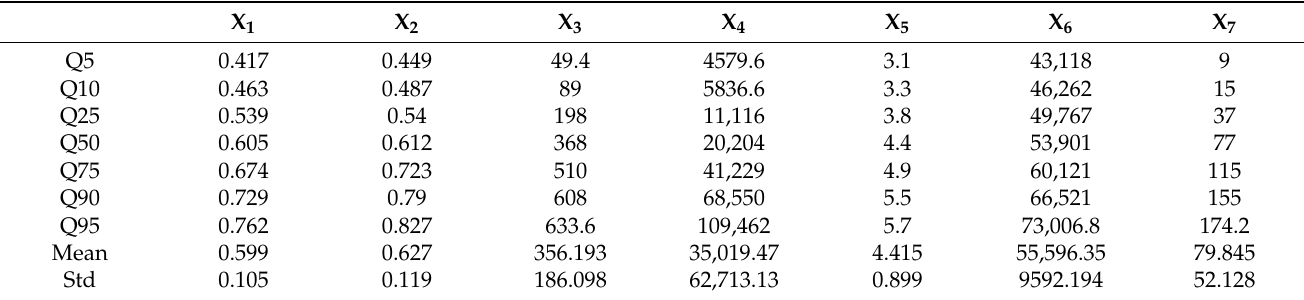
Table A2. Descriptive statistics for cluster 2.